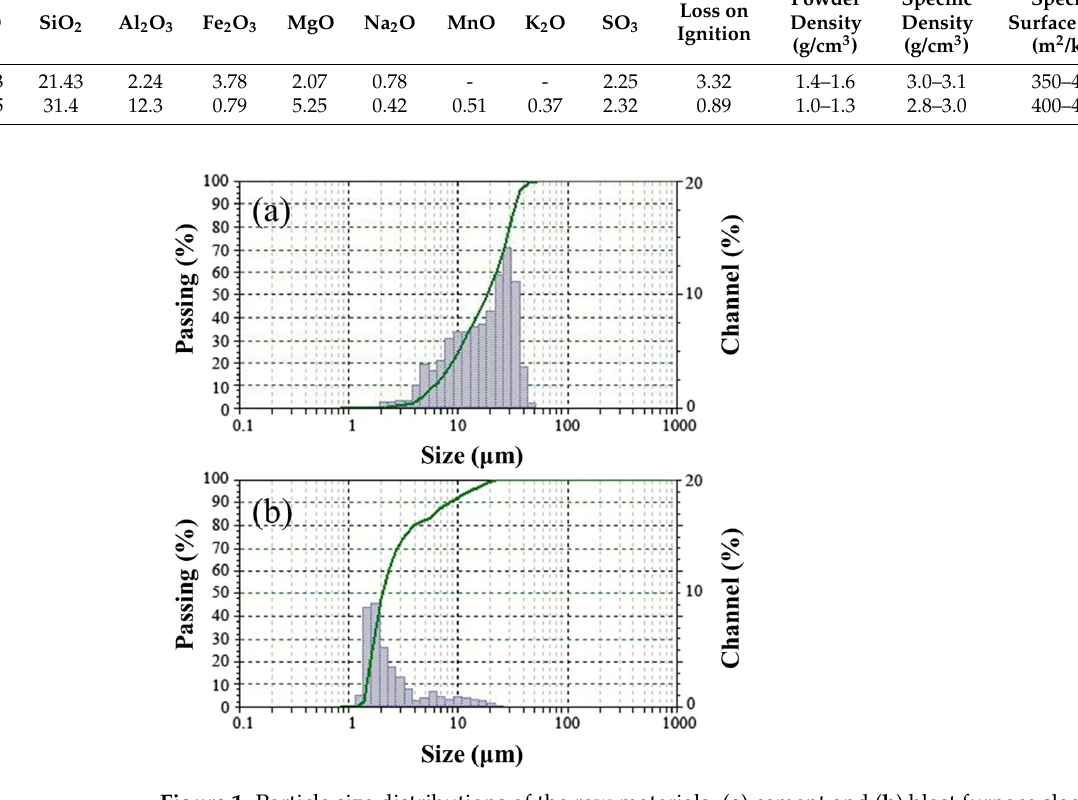
Figure 1. Particle size distributions of the raw materials: ( a ) cement and ( b ) blast furnace slag.